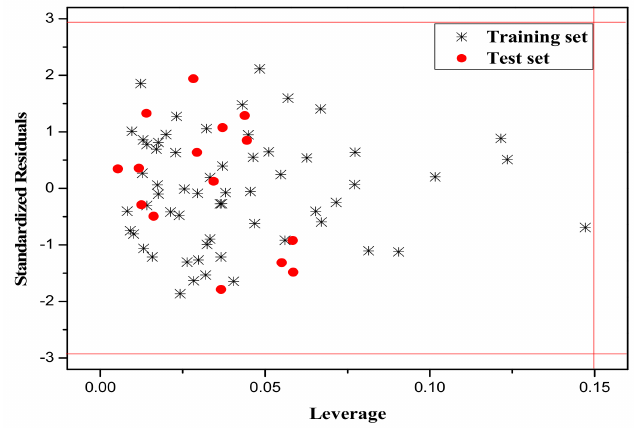
Figure 5. The William’s plot for the training and test set compounds of Group 2 by MLR model.